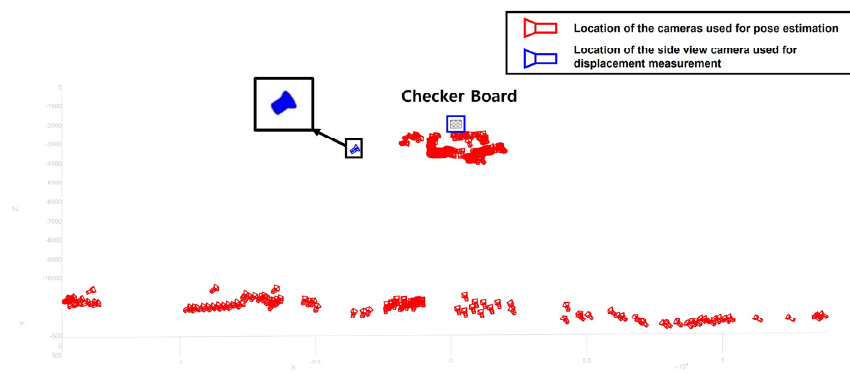
Figure 15. Camera pose estimation result for the on-site validation test.